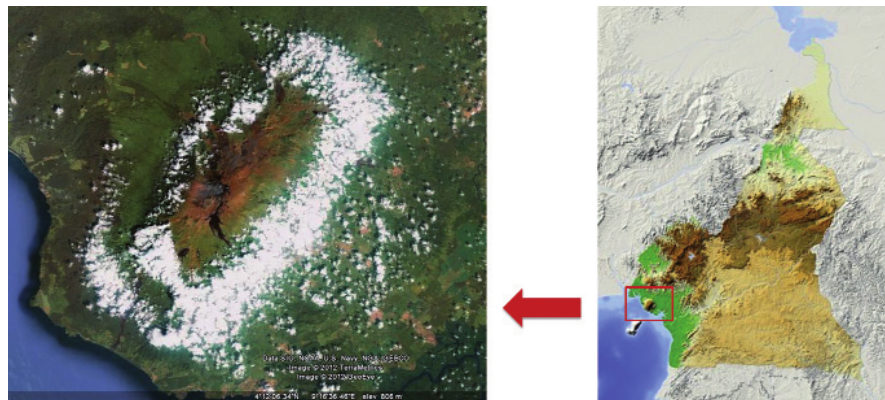
Above: Figure 3. Mount Cameroon (4095 m a.s.l.) is an active stratovolcano of dominantly basaltic composition (http://www.volcano.si.edu/world/volcano.cfm?vnum=0204-01=). Photograph on the left: Google Earth. Shaded relief map of Cameroon on the right: NASA. Bottom: Figure 4. Natural hazards in the Fako